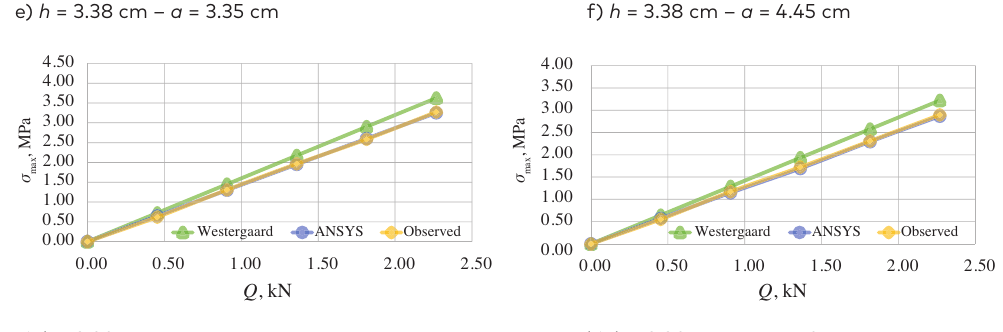
Figure 12. Load-stress relations with load in the